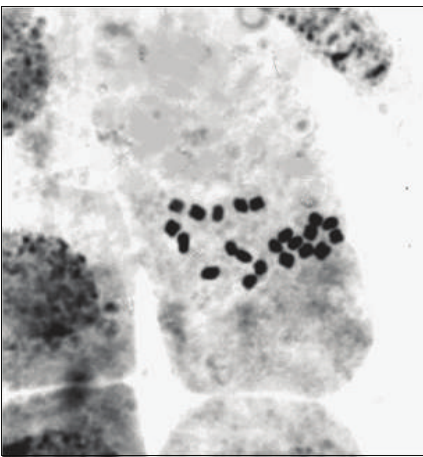
Figure 10: “Squash” preparation of meristematic cells of root tips excised from in vitro plant regenerants of Rhodiola rosea having diploid chromosome number of 2 n = 22